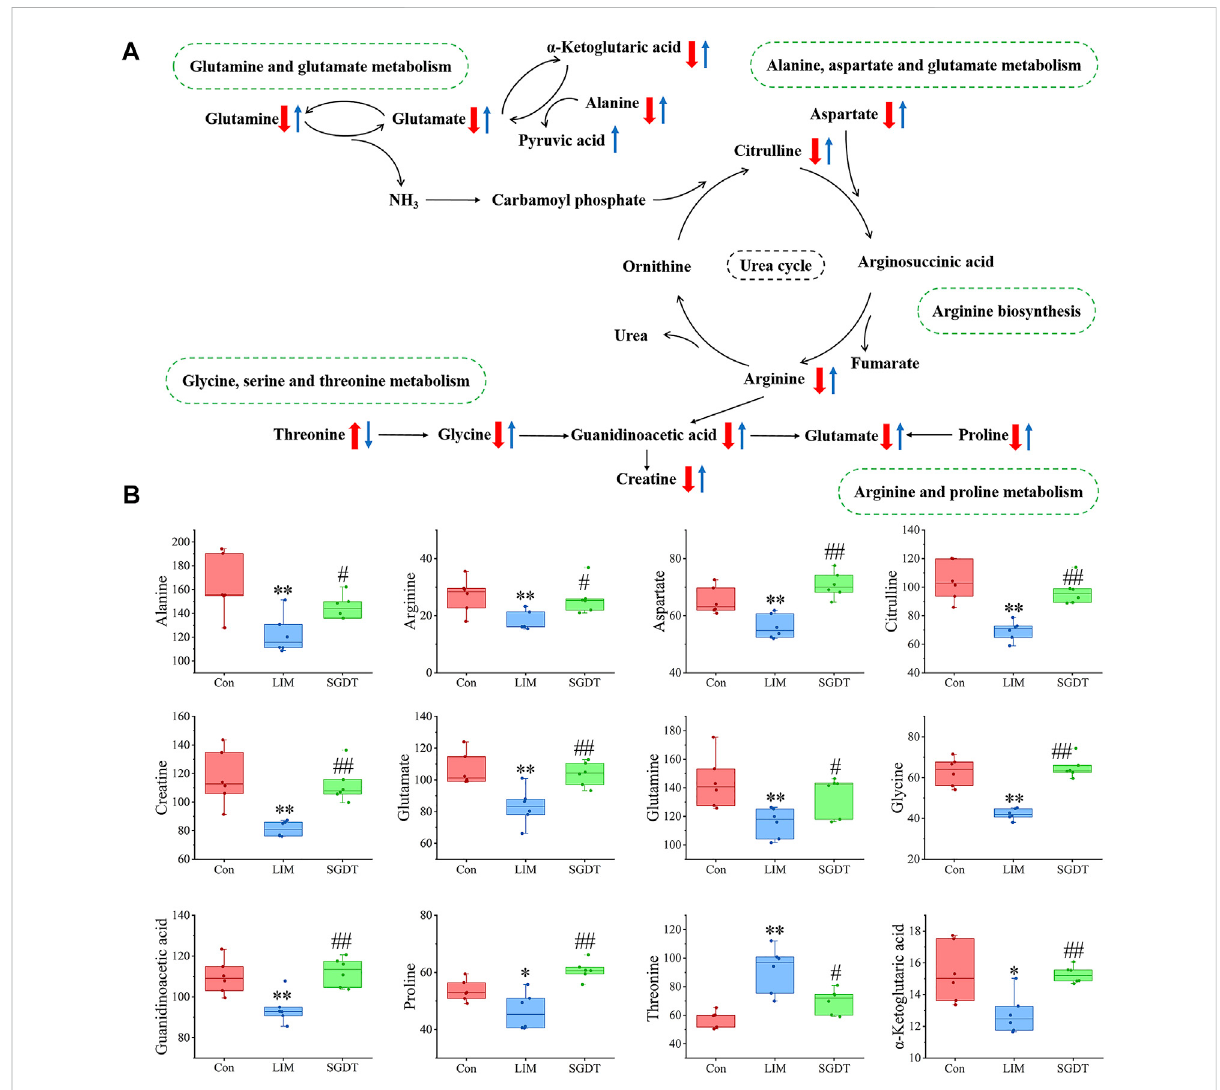
FIGURE 4 Schematic diagram of key metabolic pathways (A) and level changes of corresponding metabolites (B) . The " ↑ " or " ↓ " in (A) represents the differential metabolite which was signi fi cantly up-regulated or down-regulated, with red as compared with Con and blue as compared with LIM. In (B) , * p < 0.05, ** p < 0.01, compare with Con; # p < 0.05, ## p < 0.01, compare with